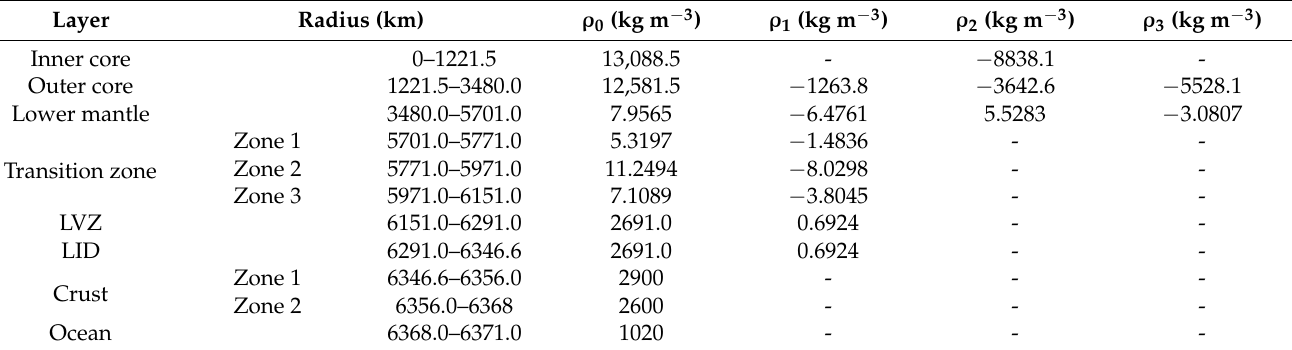
Table 1. The PREM density parameters according to